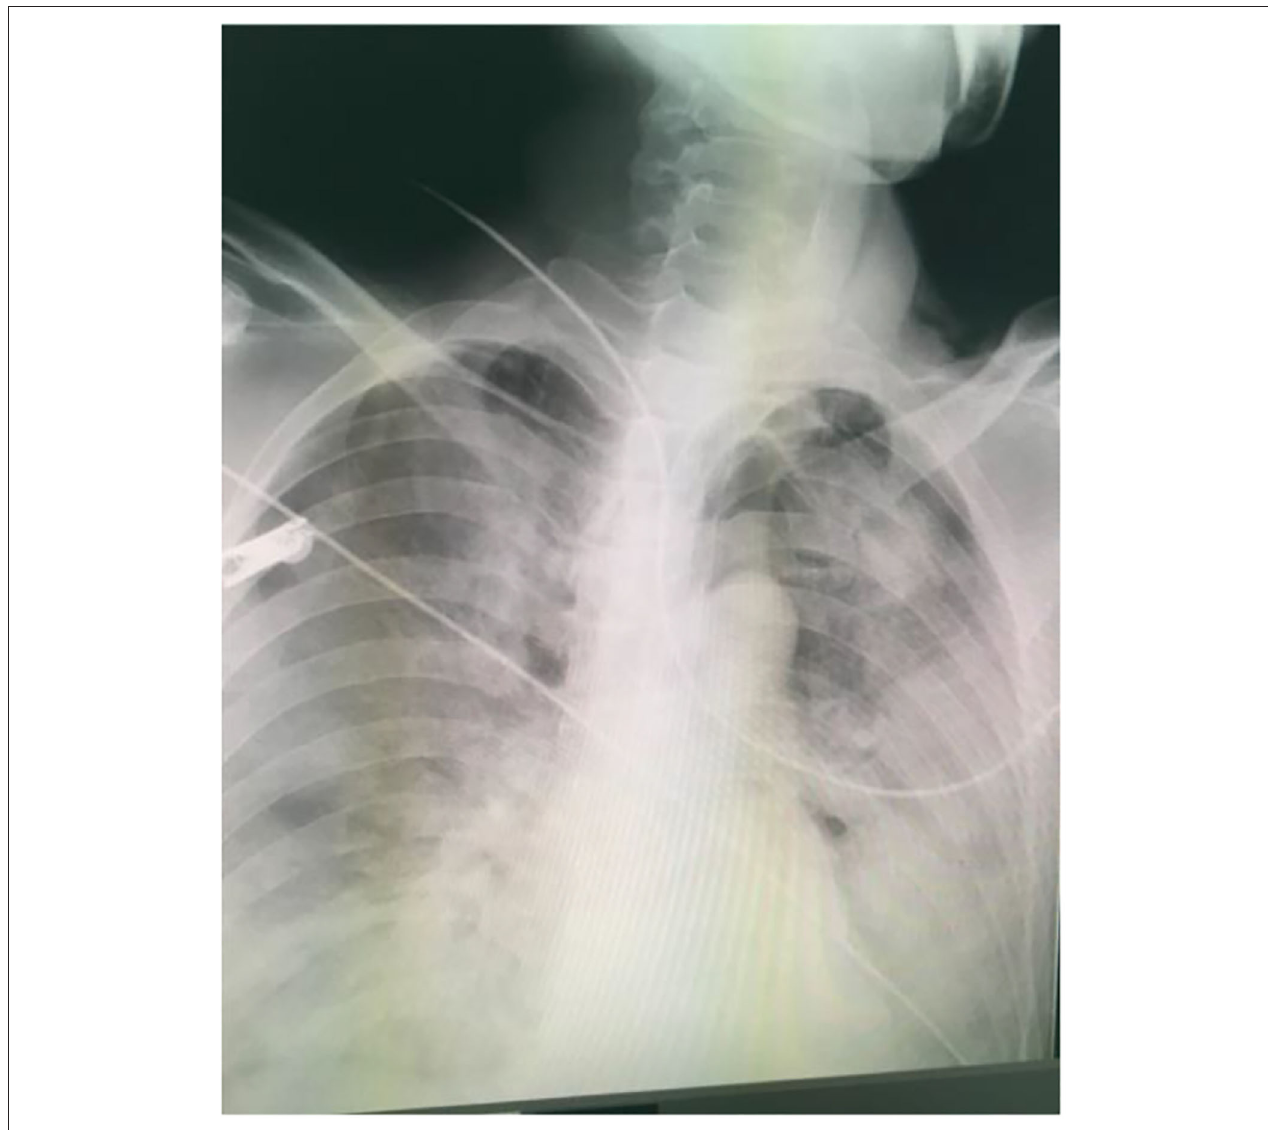
FIGURE 1 | Chest x-ray revealed pulmonary edema with fluid-filled bilateral